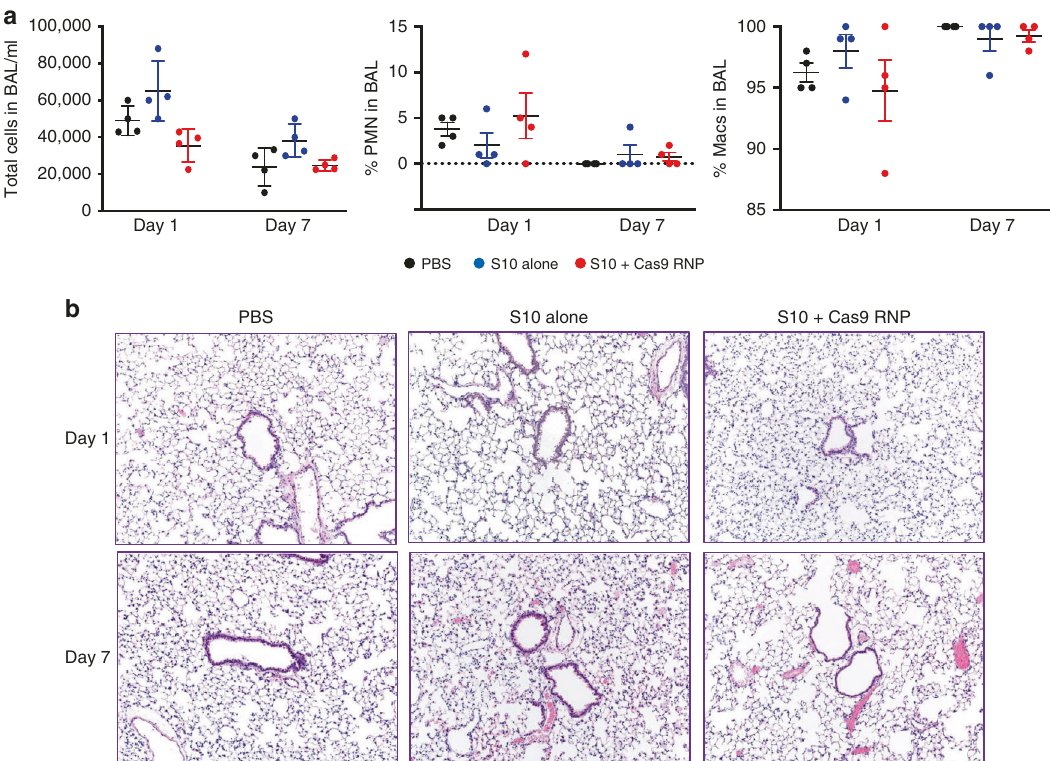
Fig. 5 Pulmonary toxicity pro fi le following in vivo delivery using S10 peptide. C57BL/6 mice received PBS alone, S10 alone, or [S10]: 40 µ M and Cas9 RNP (2.5 µ M Cas9/2.0 µ M gRNA) by intranasal instillation. a In vivo delivery of PBS, S10 alone (40 µ M), or S10 (40 µ M) and Cas9 RNP (2.5 µ M Cas9/2.0 µ M gRNA) to C57BL/6 mice by intranasal instillation. Left panel: BAL total cell counts 1 and 7 days post delivery. Middle panel: BAL neutrophil (PMN) percentage 1 and 7 days post delivery. Right panel: BAL macrophage percentage 1 and 7 days post delivery. Each point represents data from one